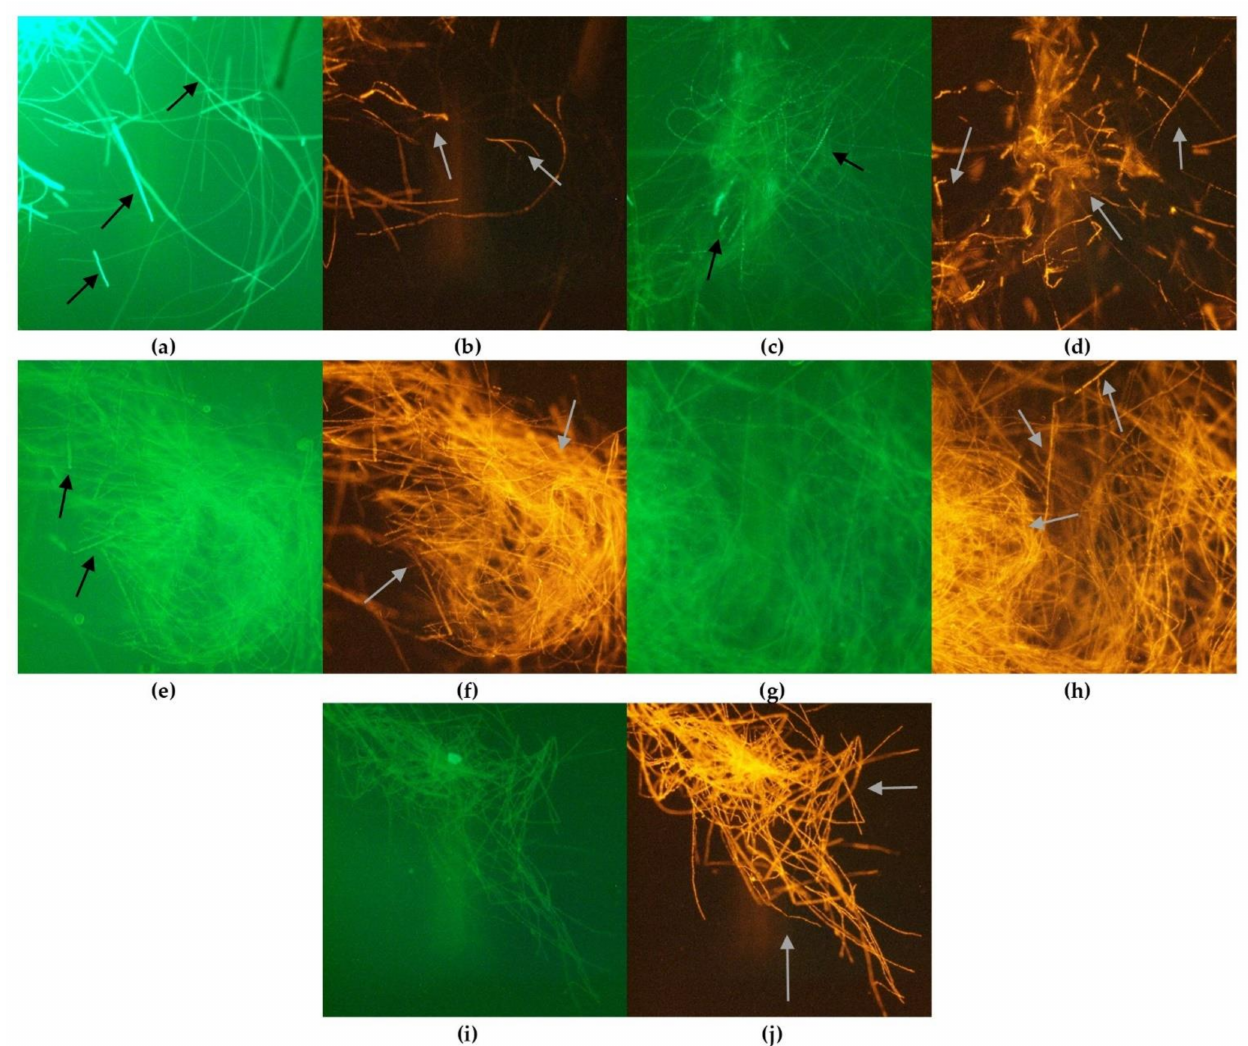
Figure 3. Morphology of F. graminearum hyphae under optical microscope (magnification × 400): untreated: ( a ) control, stained with cFDA; ( b ) control, stained with PI; treated with cinnamon EO: stained with cFDA, EO concentration: ( c ) 0.1%; ( e ) 1.0%; ( g ) 5.0%; ( i ) 10.0%; stained with PI, EO concentration: ( d ) 0.1%; ( f ) 1.0%; ( h ) 5.0%; ( j )